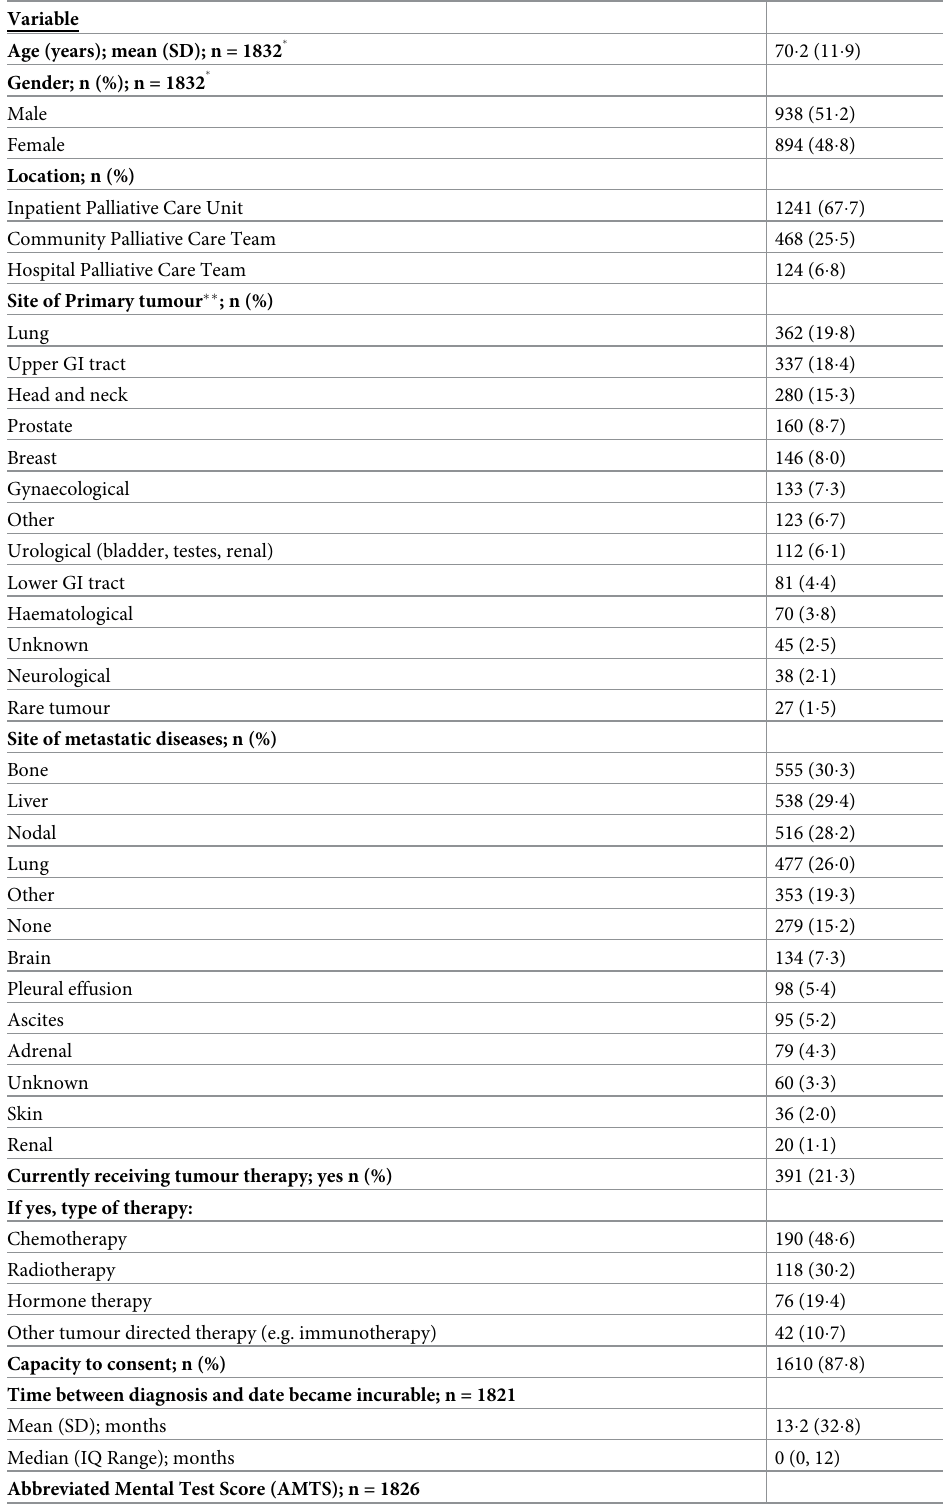
Table 2. Participant